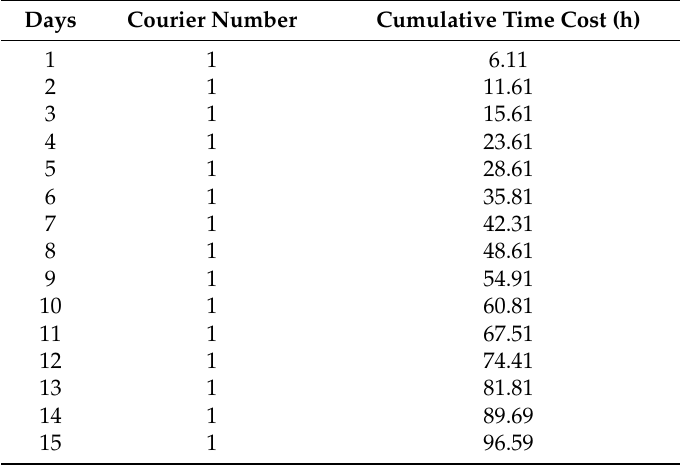
Table 3. Courier 1 cumulative time